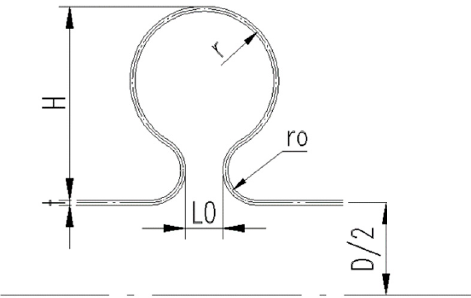
Figure 16. Dimensions of bellows in engineering practice.